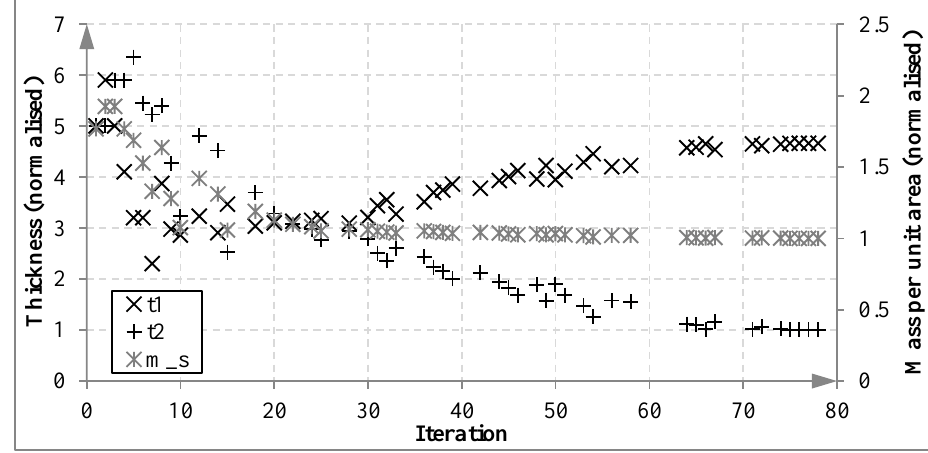
Fig. 6. Iterations leading to an optimised multi-layer protection system. Minimal thickness: 1.0. t1: front plate thickness ; t2: rear plate thickness ; m_s: mass per unit area (Normalised